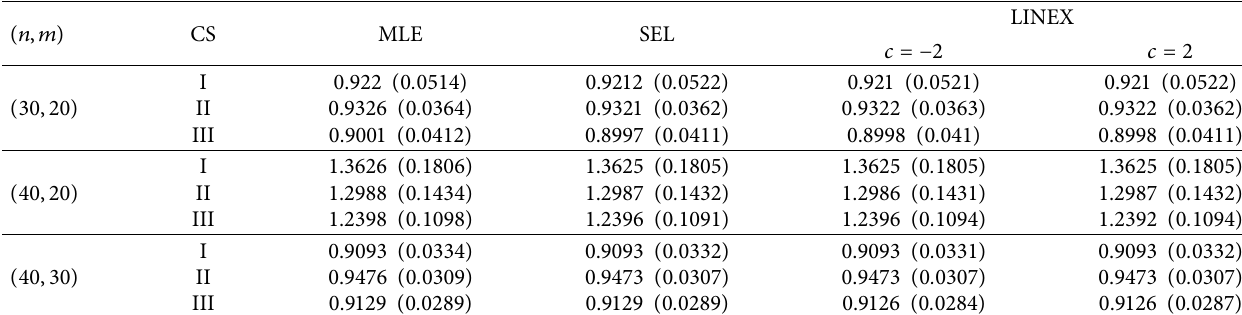
Table 8: MSE of ML and Bayesian estimates for the h ( t ) with t � 0 .